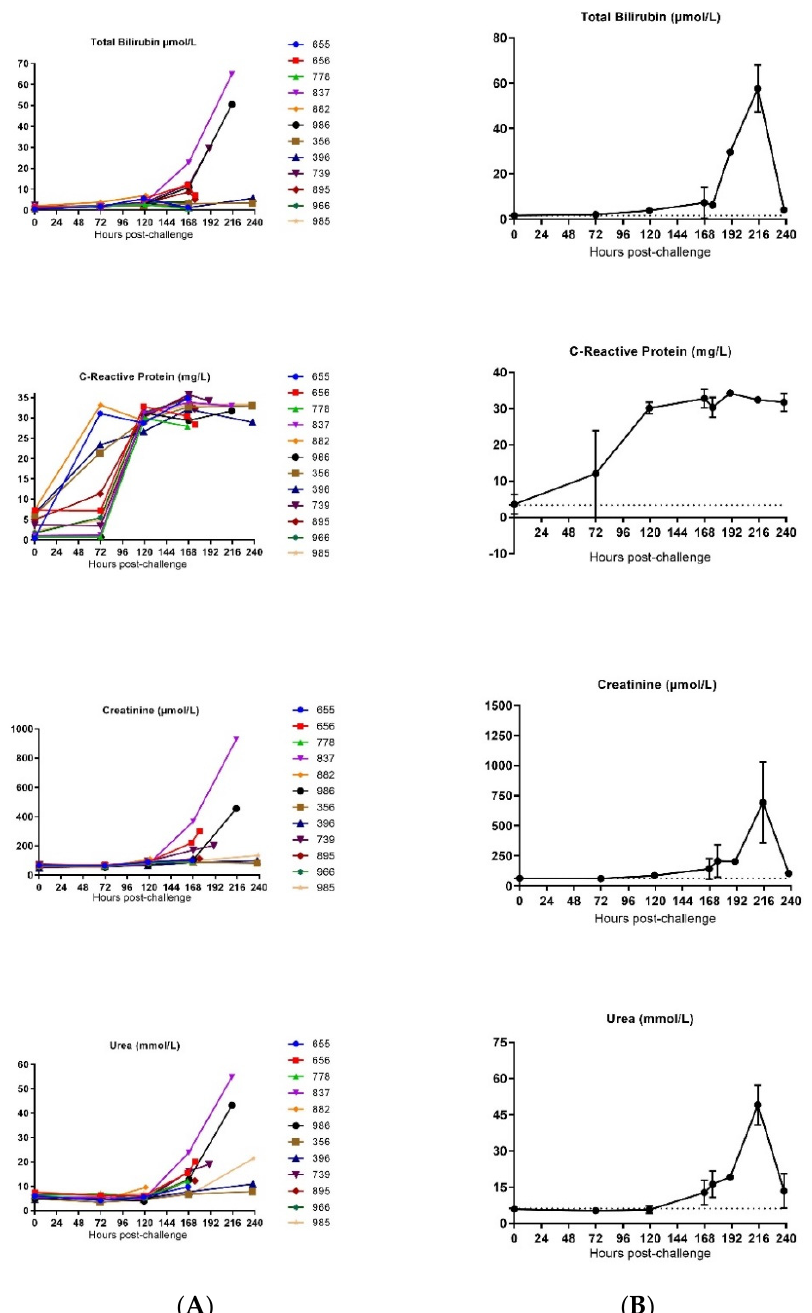
Figure 7. Biochemical analysis in SUDV-challenged animals. ( A ) Individual biochemical parameter evolution versus time. ( B ) Group mean biochemical parameter evolution versus time. Average measurements taken before exposure serve as baseline (represented by horizontal straight dashes lines). Error bars represent the standard deviation (SD) of the mean.